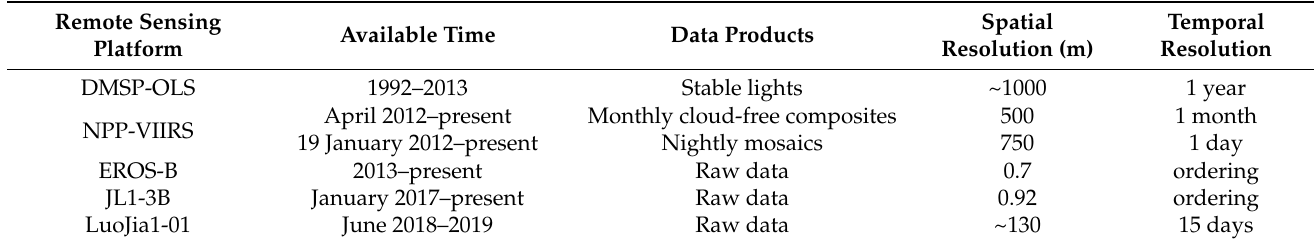
Table 1. Sensors and basic parameters of NTL